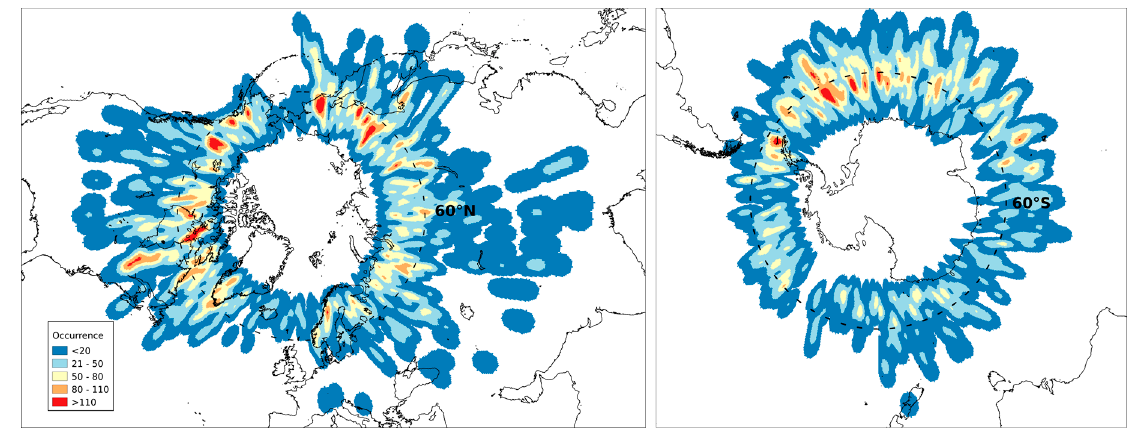
Figure 1. Global distribution of snowfall elements in the GMI-CPR coincidence dataset (March 2014– Figure May 2016). The two panels show the number of occurrences of snowfall elements (indicated by the colors) in the: Northern hemisphere ( left ); and Southern hemisphere ( right ).